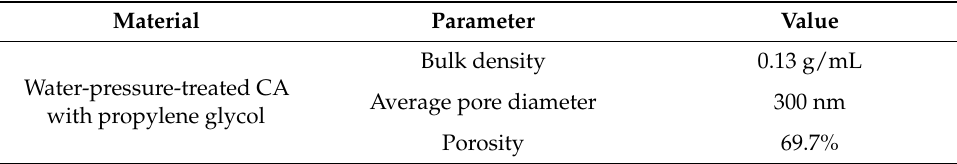
Figure 5. Log differential intrusion of 1:0.2 CA/propylene glycol (8 bar). Table 1. Porosimetry data of 1:0.2 CA/propylene glycol (8